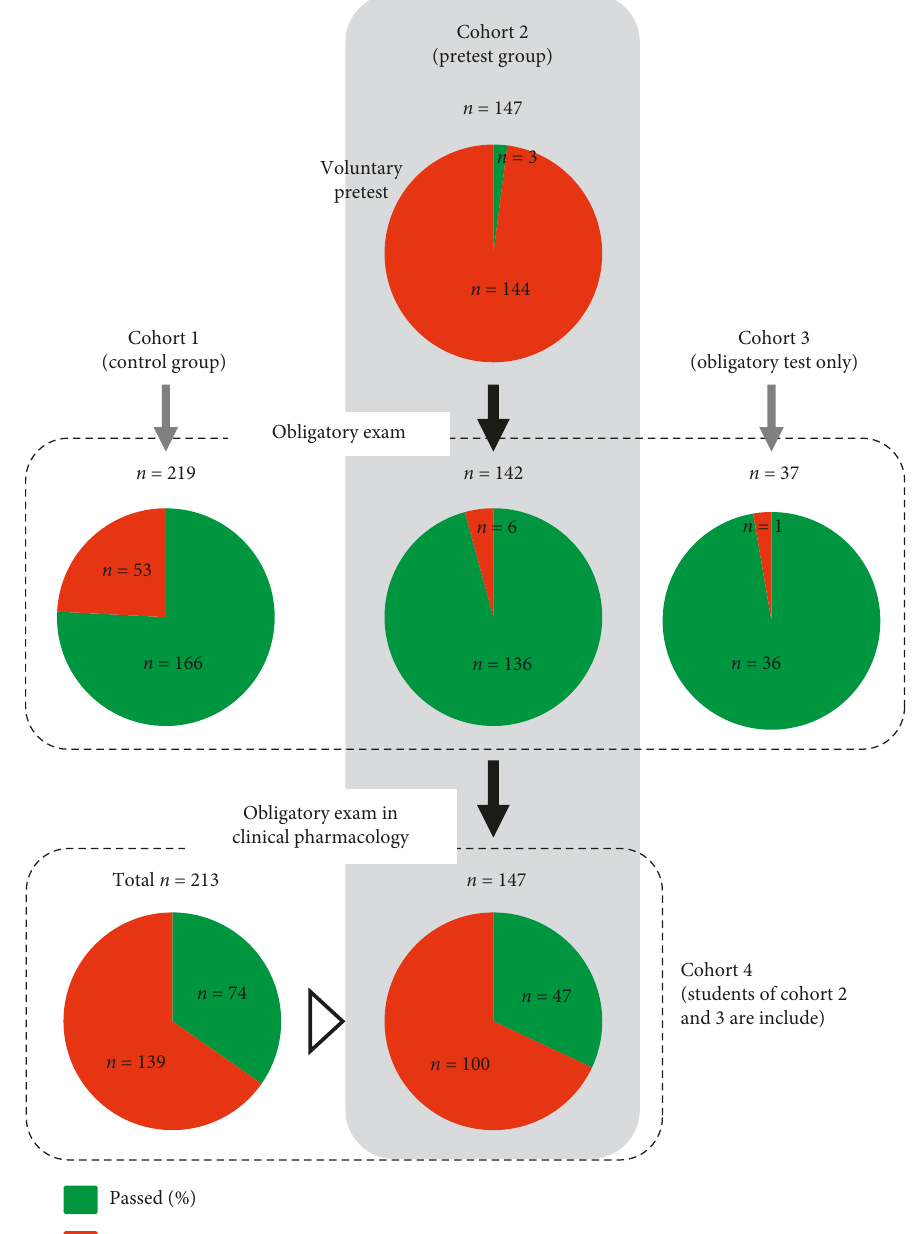
Figure 8: Percentage of students who passed and failed in the study arms (cohorts). Numbers of students are also given for each cohort. Moreover, the sequence of the study steps is reproduced in order to facilitate comparison between groups. Note that some students ( n � 39) took part at the obligatory exam in clinical pharmacology (cohort 4, n � 213) which were not part of the cohorts 1, 2 or 3. That means cohort 2 and 3 are subgroups of cohort